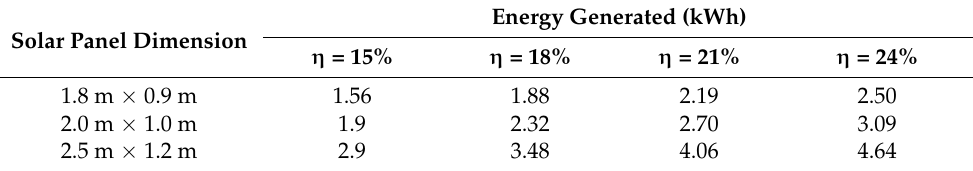
Table 1. The energy generated by different dimensions and conversion efficiency ranges as found in the market. Solar Panel